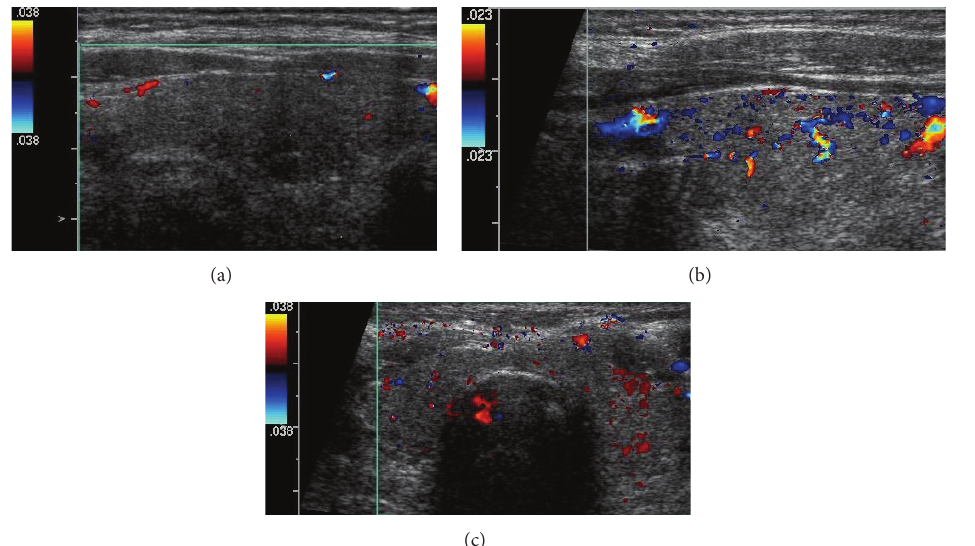
Figure 1: Thyroid ultrasound with color Doppler flow study showing normal to minimally reduced vascularity of the glandular tissue. (a) Long axis view of the right thyroid lobe. (b) Long axis view of the left thyroid lobe. (c) Transverse axis view of both lobes of thyroid gland including the isthmus.